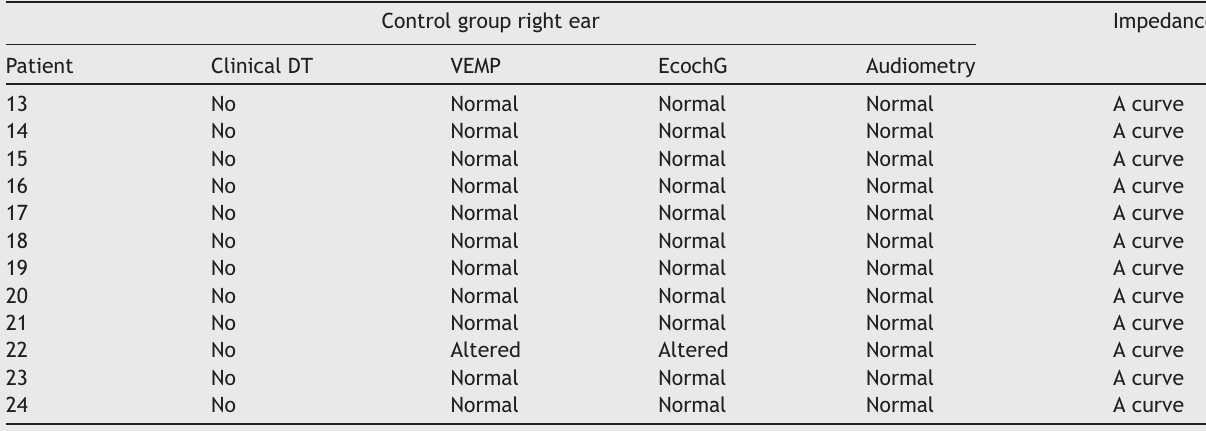
Individual results of the right ear in the control